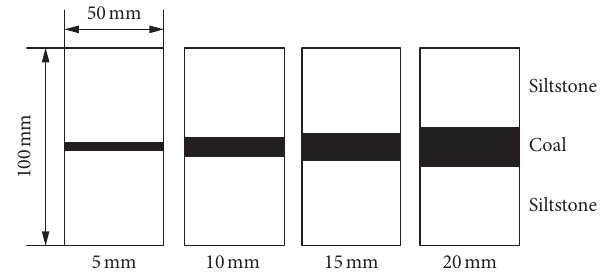
Figure 2: Illustration of samples with coal joints of different